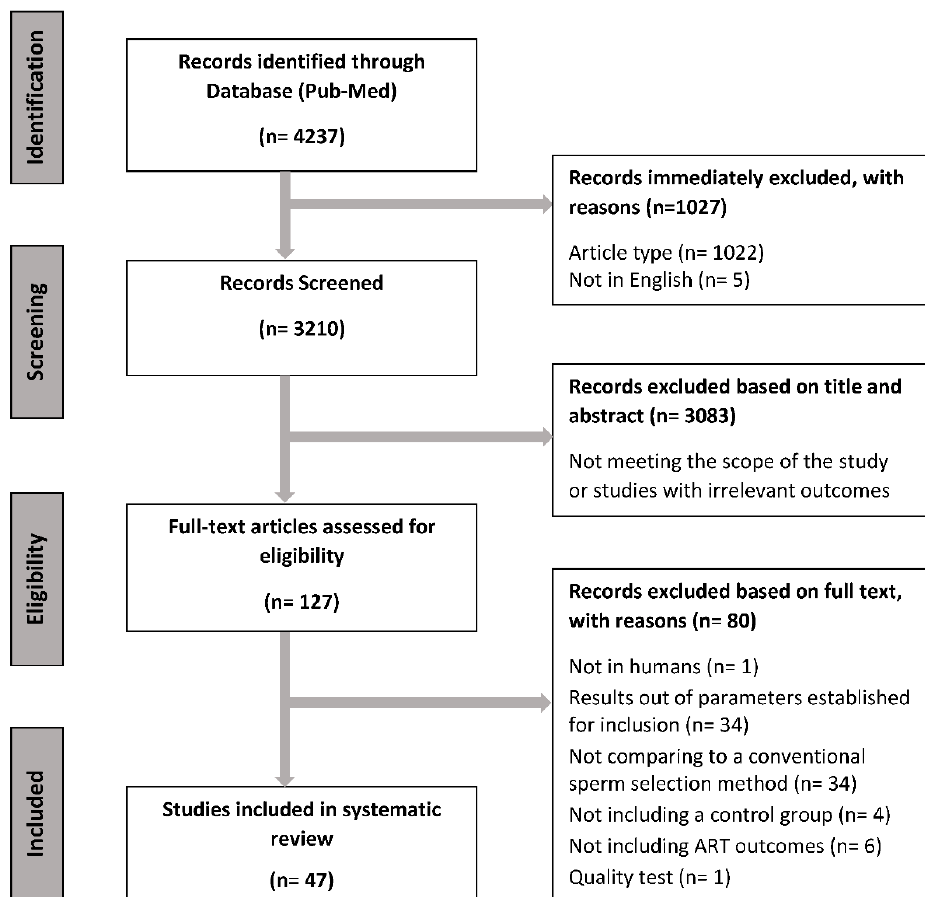
Figure 1. Flowchart of the literature search and selection procedure.